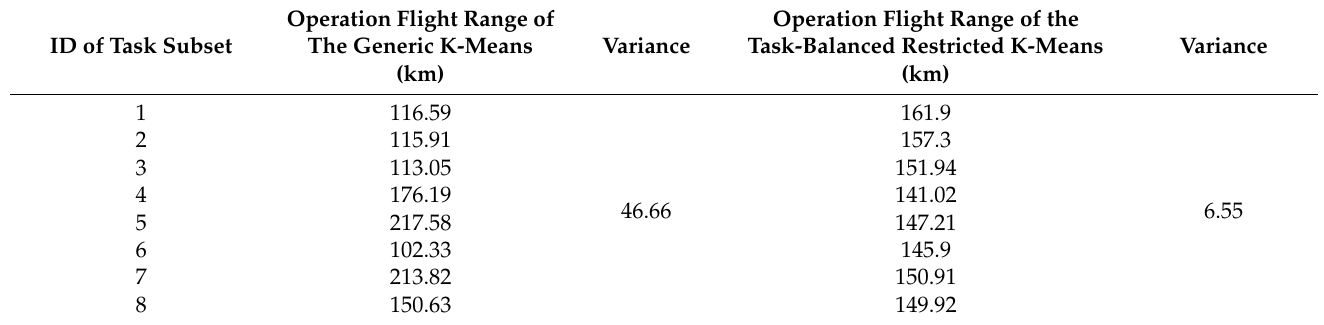
Table 2. Results of the task set decomposition for the generic K-means and task-balanced restricted